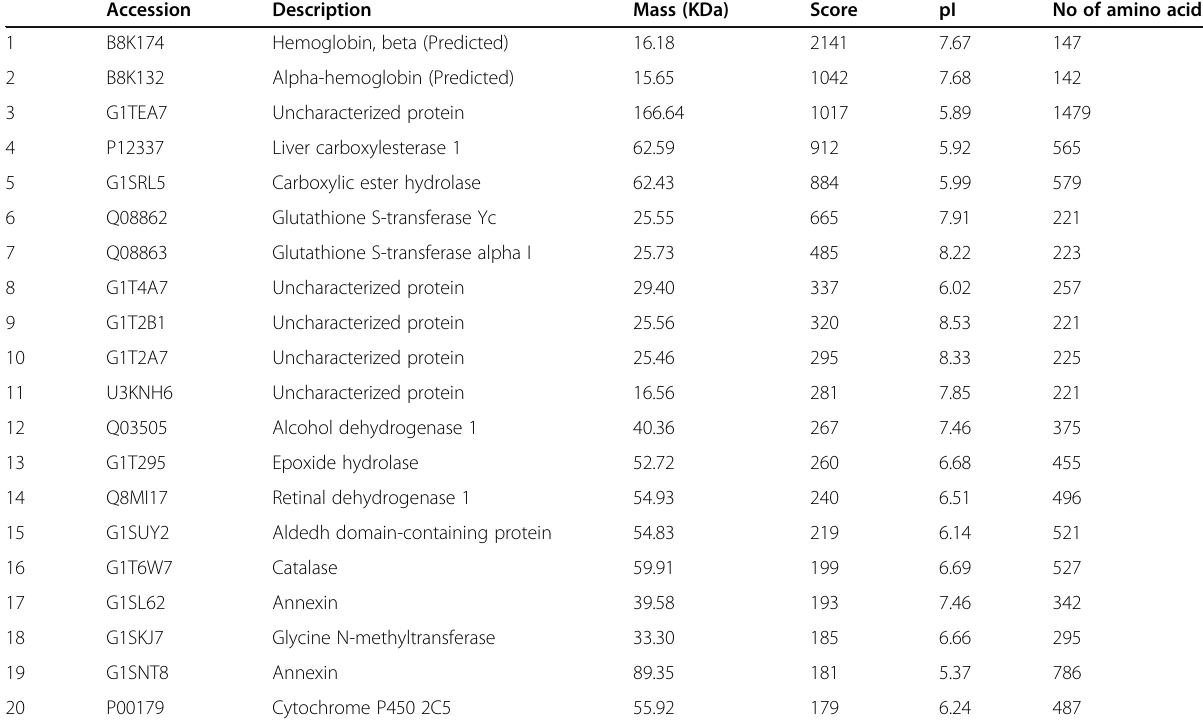
Table 1 List and physicochemical properties of topmost abundant proteins in the liver proteome of the rabbits in the control group